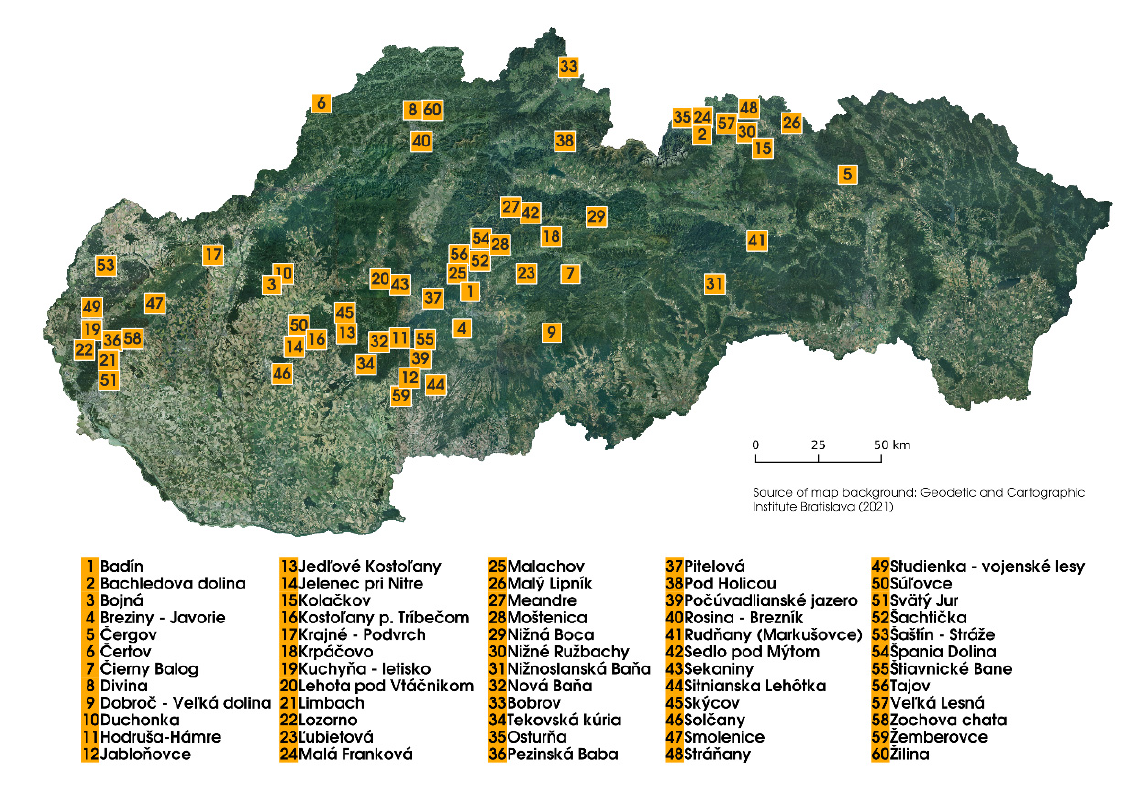
Figure 1. Wild-growing edible mushroom sampling sites. Table 1. The occurrence of individual mushroom species in the sampling